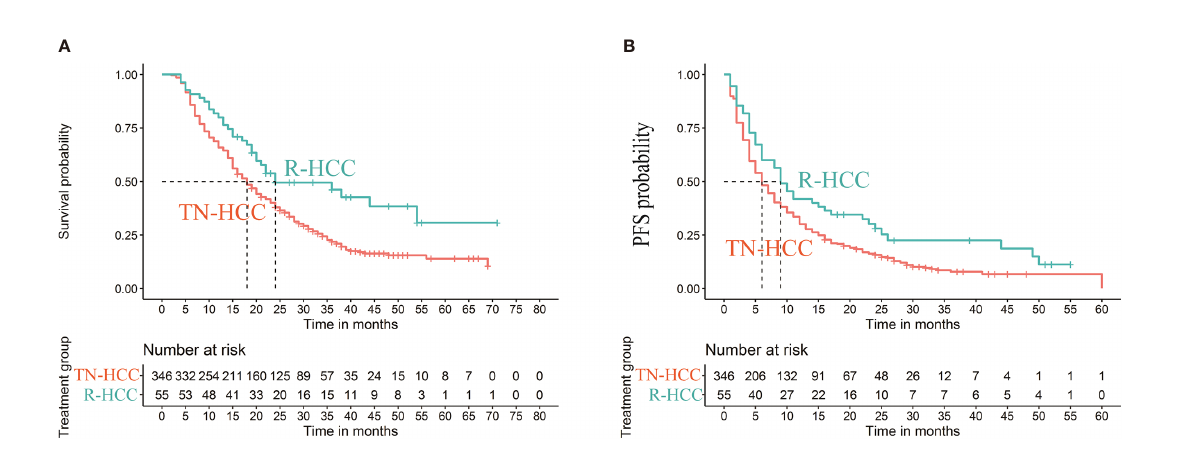
a survival signature were identi fi ed ( Figure 5A, B ). Patients entered into different subgroups according to tumor size, BCLC stage, and TACE sessions and shared different hazards ratio to recurrence or survival ( Table 4 ).